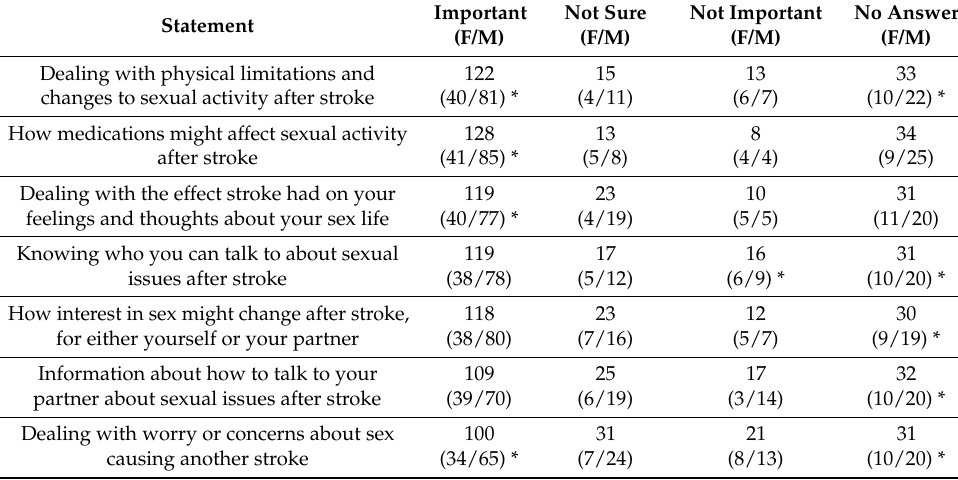
Table 4. Types of information that would be helpful